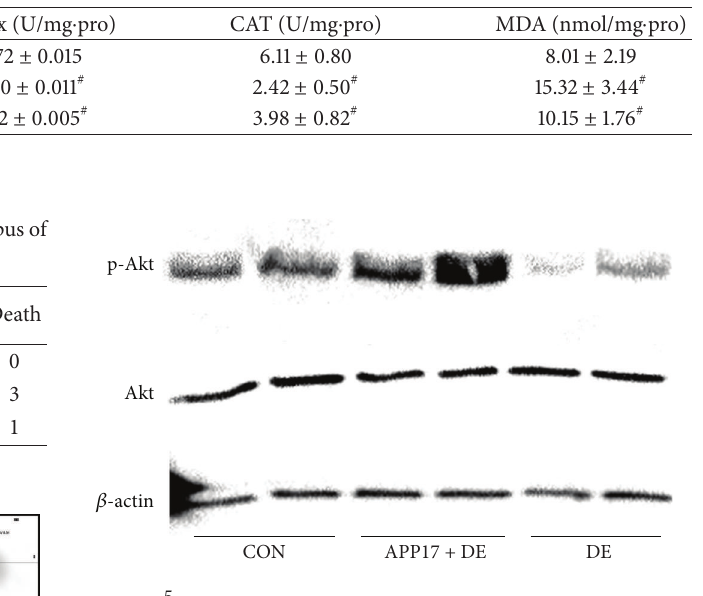
Table 2: Changes on biochemistry of rats in 3 groups ( 𝑥 ± 𝑠 , 𝑛 = 10).